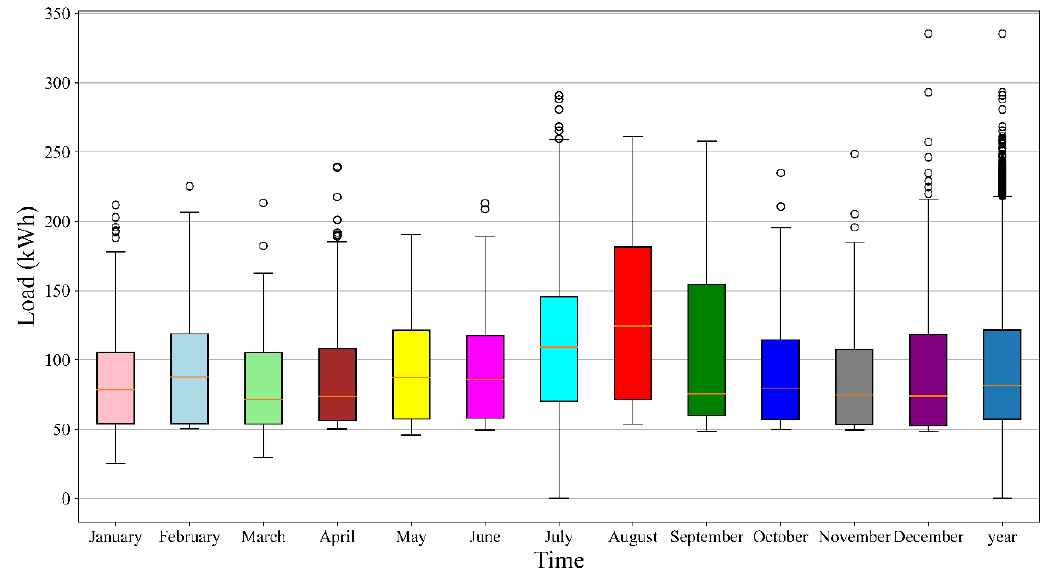
Figure 12. Box plot of energy consumption distribution in 12 months and the whole year.